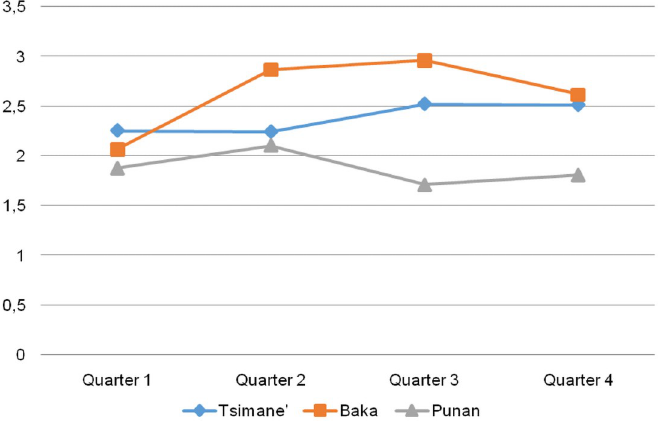
Fig 3. Average life satisfaction score, by quarter of data collection and society. Tsimane’: Quarter 1, n = 90; Q2, n = 86; Q3, n = 69; Q4, n = 41; Baka: Quarter 1, n = 46; Q2, n = 15, Q3, n = 123, Q4, n = 39; Punan: Quarter 1, n = 48; Q2, n = 49; Q3, n = 55; Q4, n = 31.